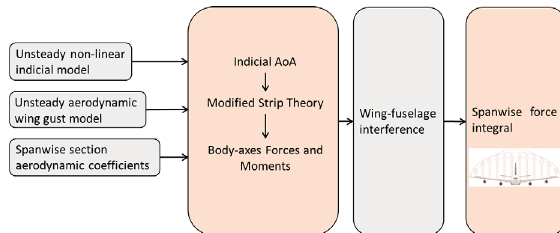
Fig. 3. Modelling of aerodynamic surfaces in the CA 2